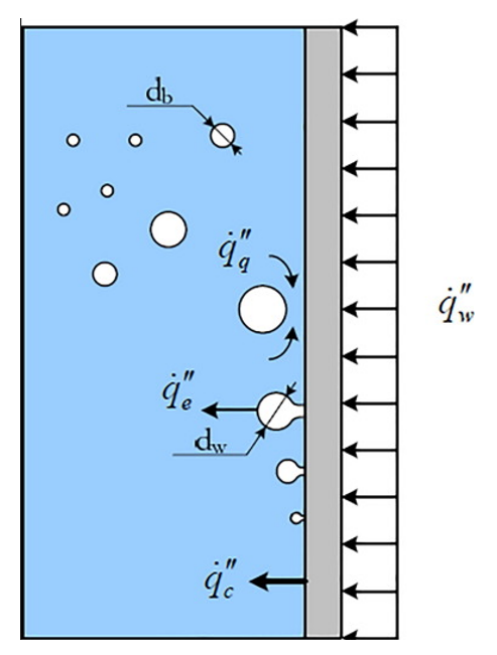
Figure 1. Diagram of the heat flux wall partitioning (Kurul and Podowski [1]), q ” e is the evaporation heat flux, q ” q is the quenching heat flux, and q ” c is the single-phase convective heat